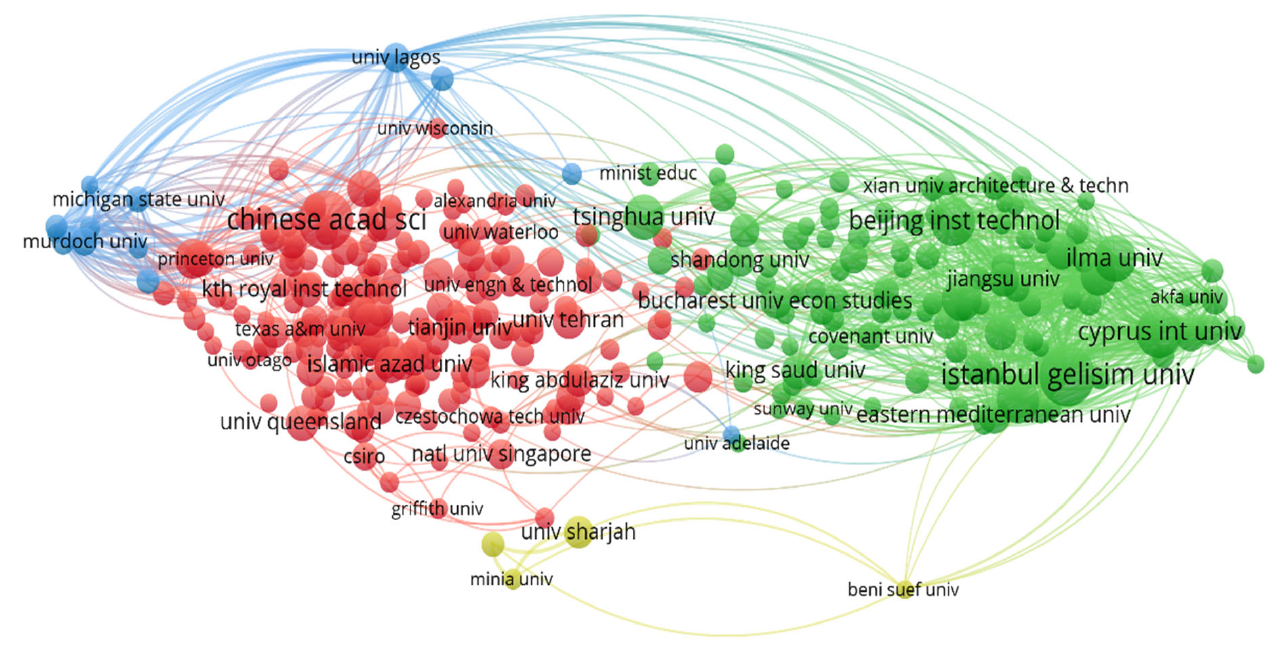
Figure 3. A bibliographic linkage map by authors with at least 30 citations using citation analysis software VOSviewer. Source: elaborated on the basis of WoS and VOSviewer.